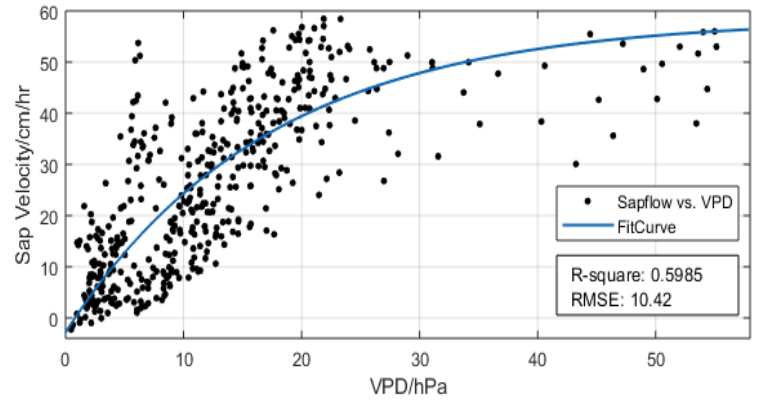
Figure 5. The non-linear fit between the sap flow rate and VPD.